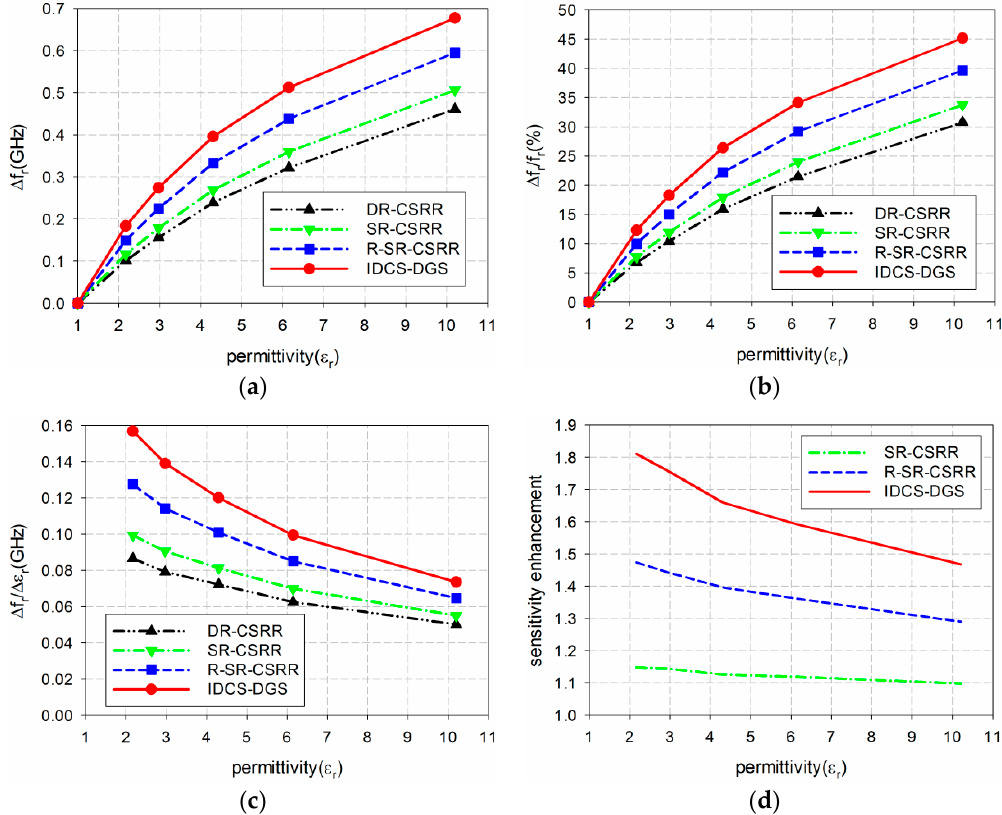
Figure 11. Simulated sensitivity comparison of the four permittivity sensors: ( a ) frequency shift ( Δ f r (GHz)); ( b ) percent relative frequency shift ( Δ f r /f r (%)); ( c ) sensitivity( Δ f r / Δ ε r (GHz)); ( d ) sensitivity enhancement compared to the DR-CSRR-based sensor.